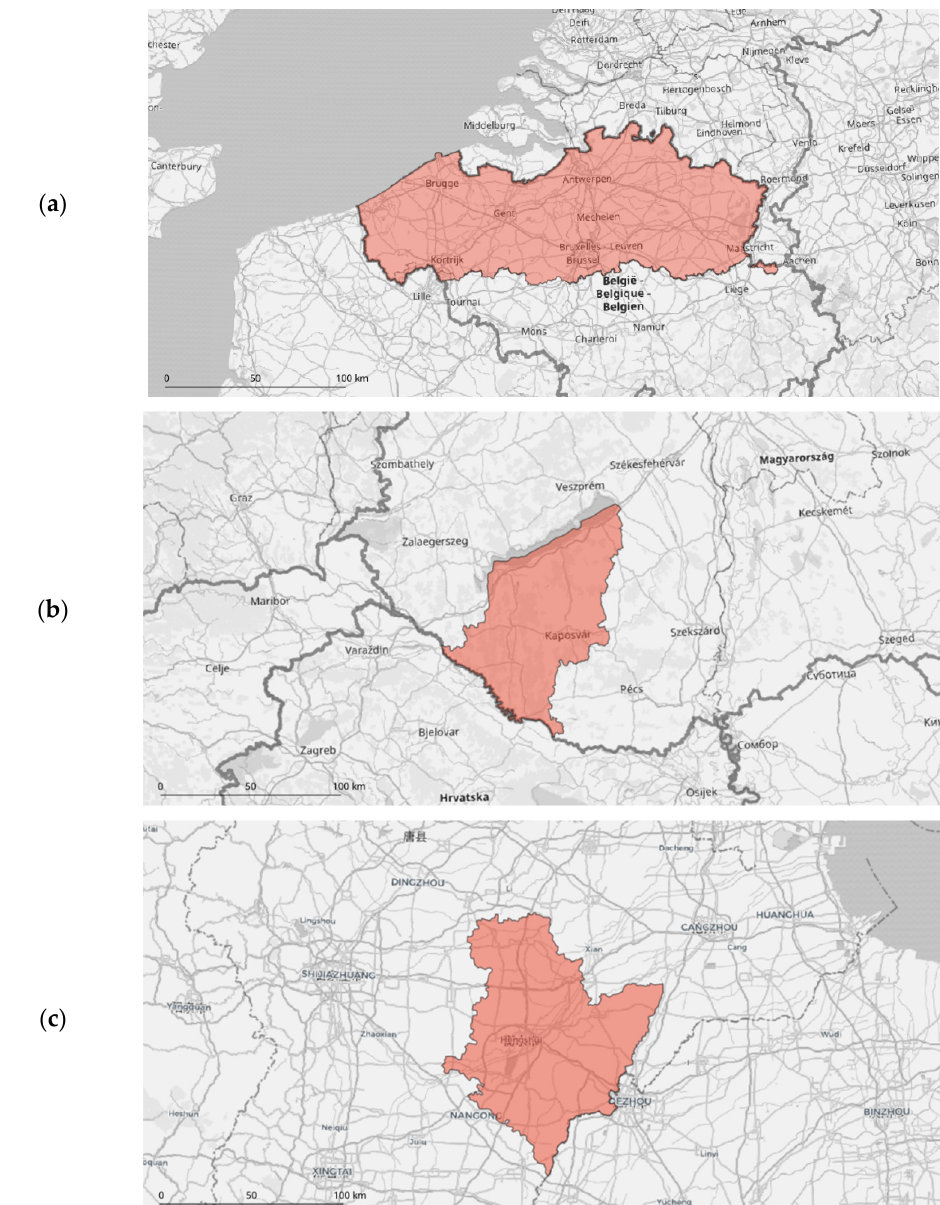
Figure 2. Location of test sites: ( a ) Flanders (BE), ( b ) Somogy (HU), and ( c ) Hengshui (CH). Somogy is an administrative county that lies in south-western Hungary, on the border with Croatia, with an area of 6064 km 2 (Figure 2b). The main crops in the area are wheat, potato, maize, alfalfa, and sugar beets. Somogy constitutes two distinct regional units: the northern region, known as Outer Somogy, and the flatter, forested, and southern region, known as Inner Somogy, while Lake Balaton and the Drava River may also be regarded as geographically distinct regions. Clay and sandy soils are characteristic of this region. Peat and swampy forest floors indicate that this area was covered with extensive forests, swamps, and bogs in the past. The proportion of the county’s forest area remains very high (Somogy is the third most forested county), while the proportion of arable land, gardens, and orchards is below the national average. Somogy has a marine west